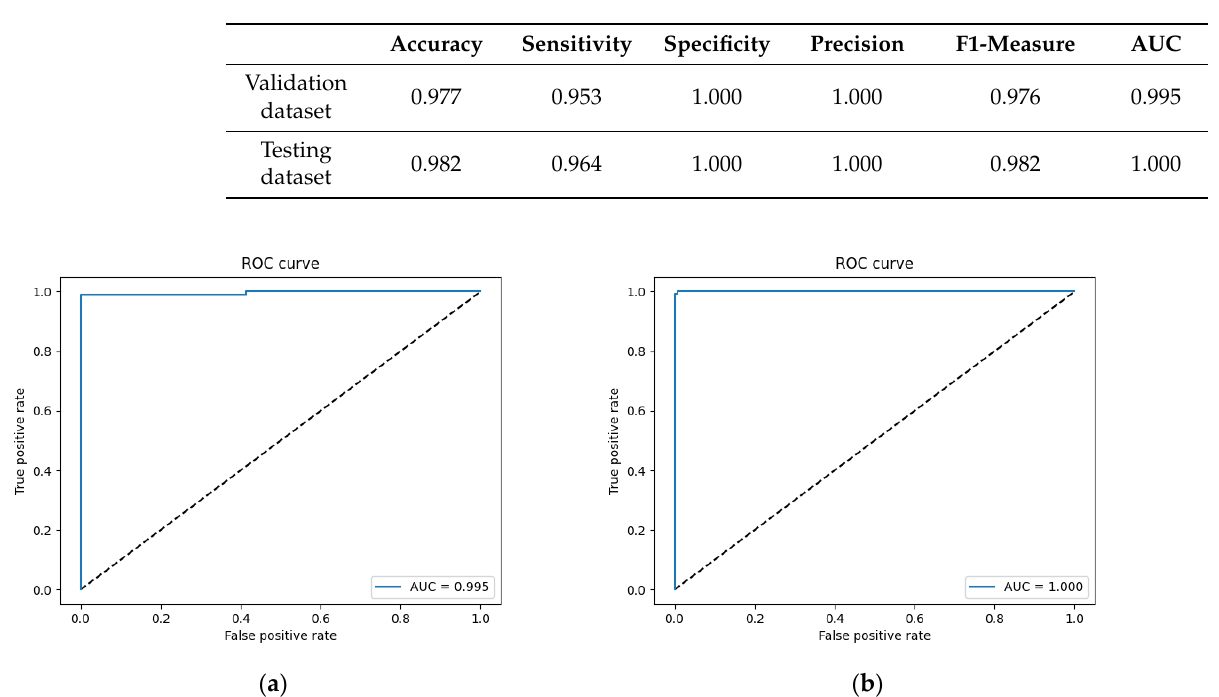
Table 2. Performance of ResNet model on our dataset.